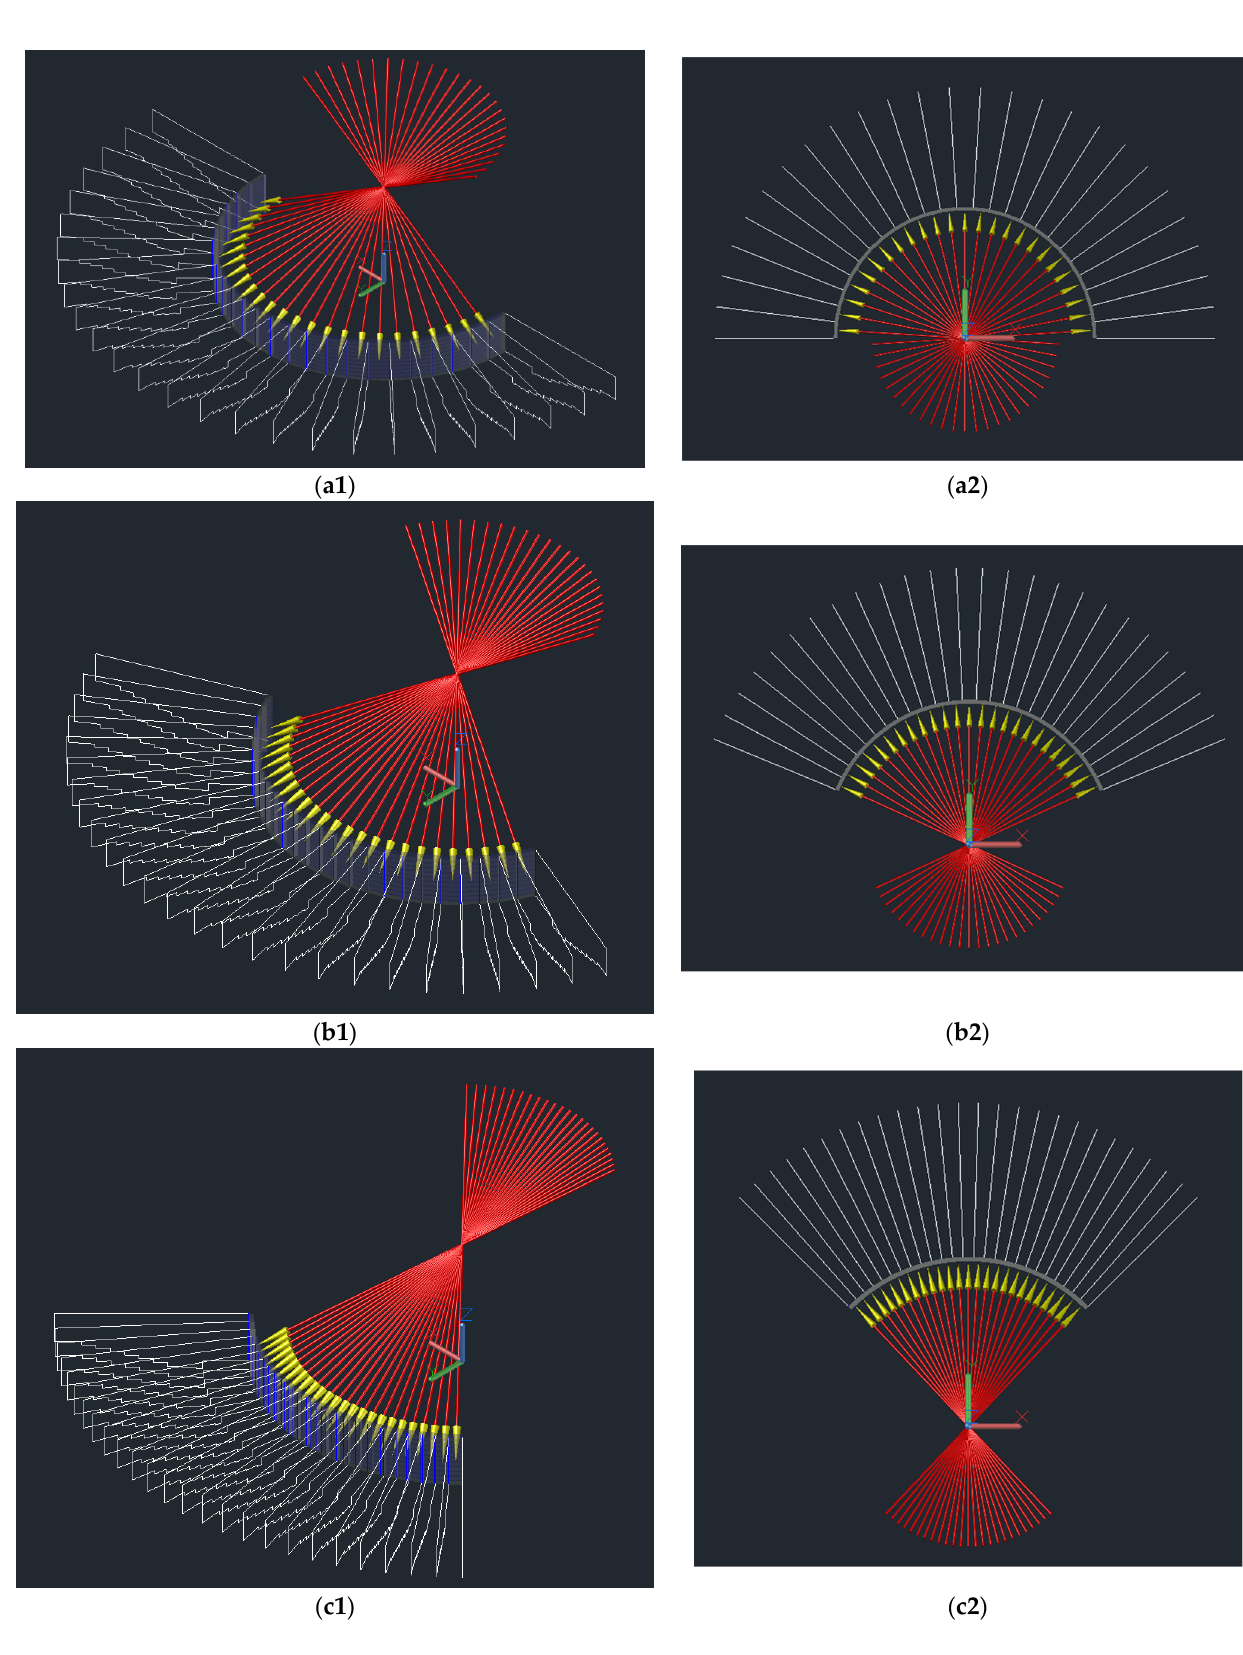
Figure 6. Scheme of the auditorium construction methodology, using a two-dimensional vertical section, and the semi-circular DSF solar radiation. ( a1 , a2 ) Case D, ( b1 , b2 ) Case E, and ( c1 , c2 ) Case F. Figures with index 1 represent the three-dimensional southeast view of the semi-circular DSF and the auditorium, while Figures with index 2 represent the top view.